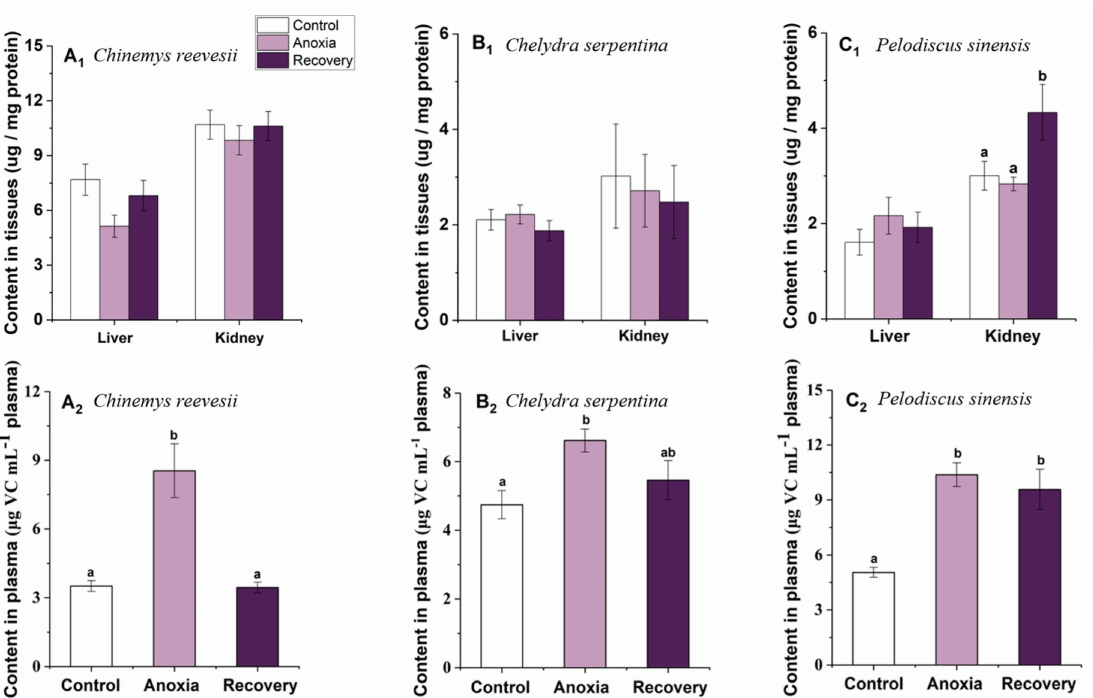
Figure 11. Changes of anoxia stress on VC content in tissues and plasma of C. reevesii ( A ), C. serpentina ( B ) and P. sinensis ( C ). Data are presented as mean ± SE. N = 10. Data with no common lowercase letters on the bar indicate significant differences between different groups ( p < 0.05).